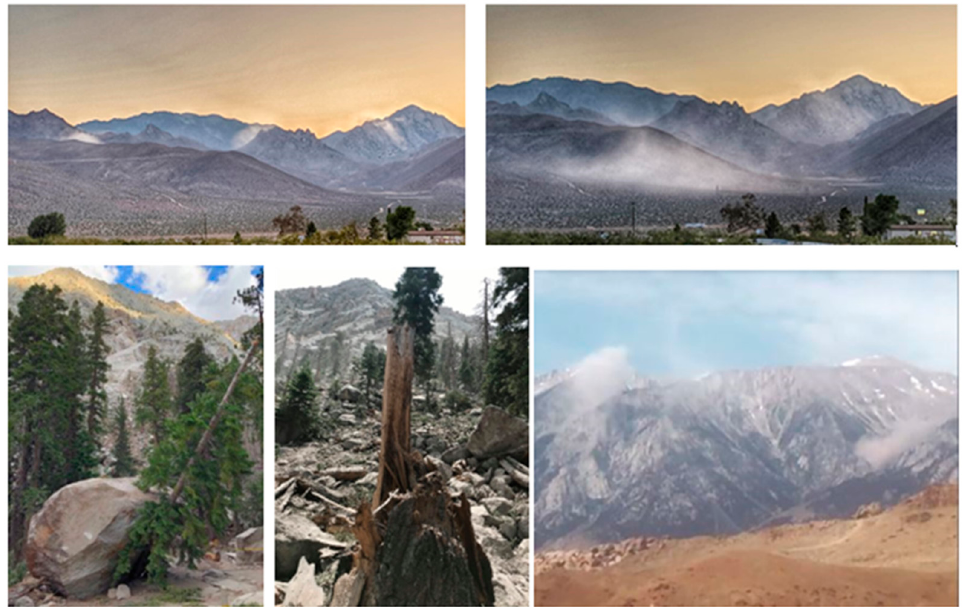
Figure 5. Dust clouds and debris fields from both events. Top left: rockfalls coincident with the Ridgecrest earthquake. Top right: dust clouds from the Ridgecrest event moving across the region shortly afterwards. Bottom left: Whitney Portal rockfall with large boulder in campground. Bottom center: rockfall debris field just above and southwest of the Whitney Portal Campground. Bottom right: dust clouds from the Owens Lake earthquake rockfalls moving across the region. The dust cloud on the right is from failures on a 200 m high rock face on lower Diaz Creek. (Ridgecrest images with permission from of Elaine Jackson. Whitney Portal rockfall images with permission from Carma Roper of the Inyo County Sheriff’s Department. Owens Lake dust cloud image with permission from Steven Wheeler).